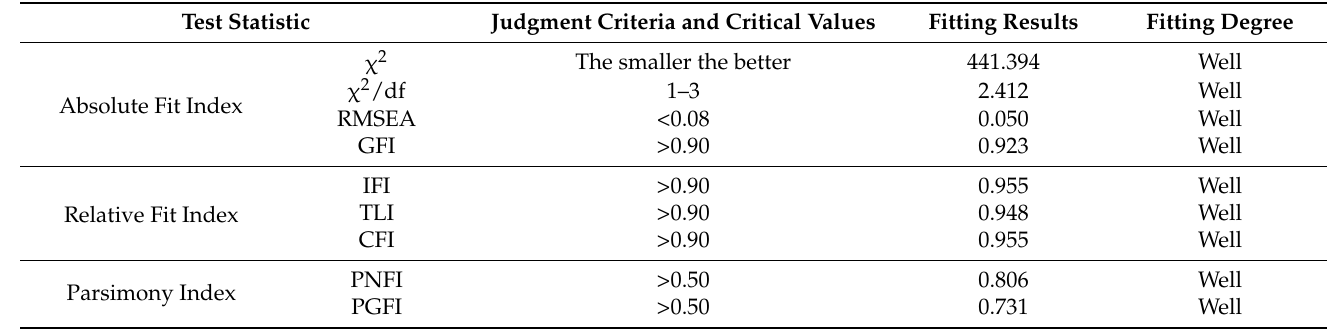
Table 4. Model fit